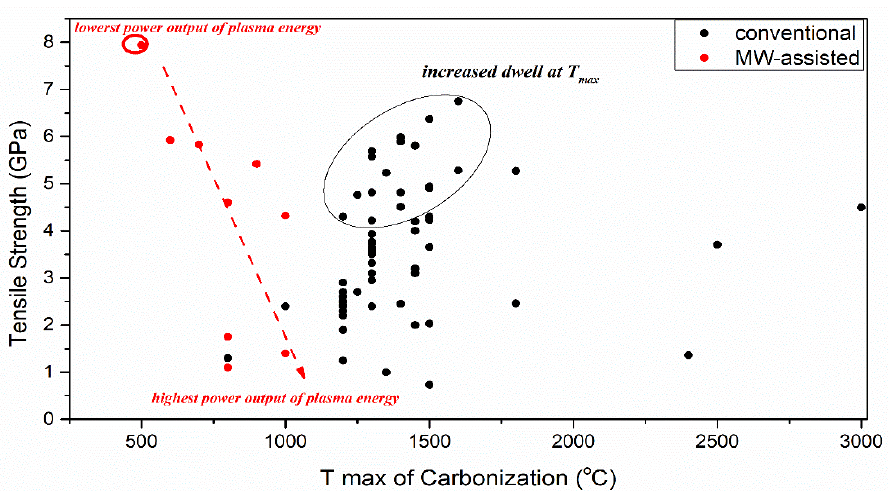
Figure 8. Dependence of Tensile strength on maximum temperature of carbonization based on literature data presented in Figure 3. Fibers 2020 , 8 , x FOR PEER REVIEW